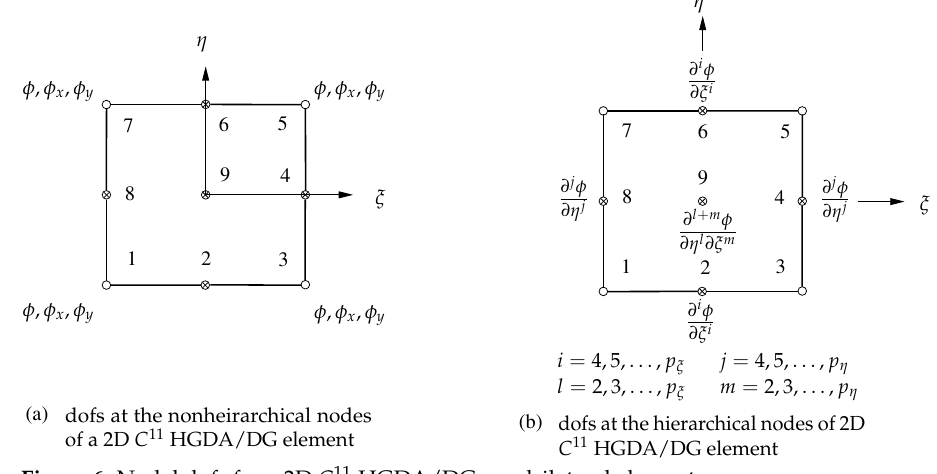
Figure 6. Nodal dofs for a 2D C 11 HGDA/DG quadrilateral element.